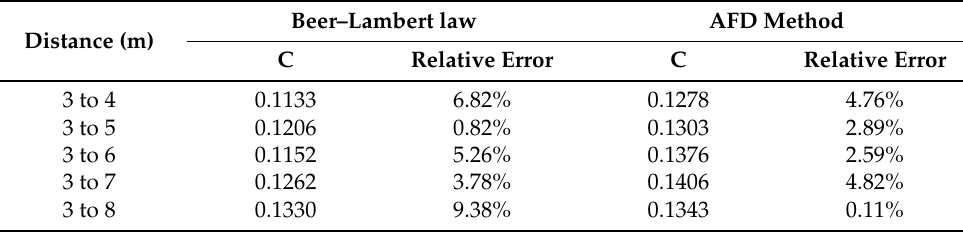
Table 2. Relative error of Beer–Lambert law and AFD method at different distance ranges. Beer–Lambert law AFD Method Distance (m) C Relative Error C Relative Error 3 to 4 0.1133 6.82% 0.1278 4.76% 3 to 5 0.1206 3 to 6 0.1152 3 to 7